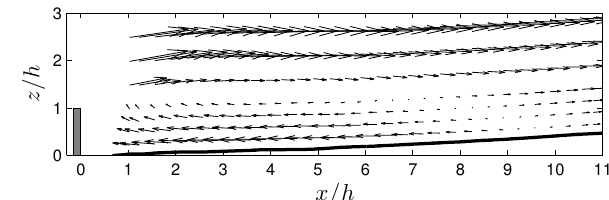
Figure 12. Velocity vector downwind the fence based on the CFD simulation for θ = 0 ◦